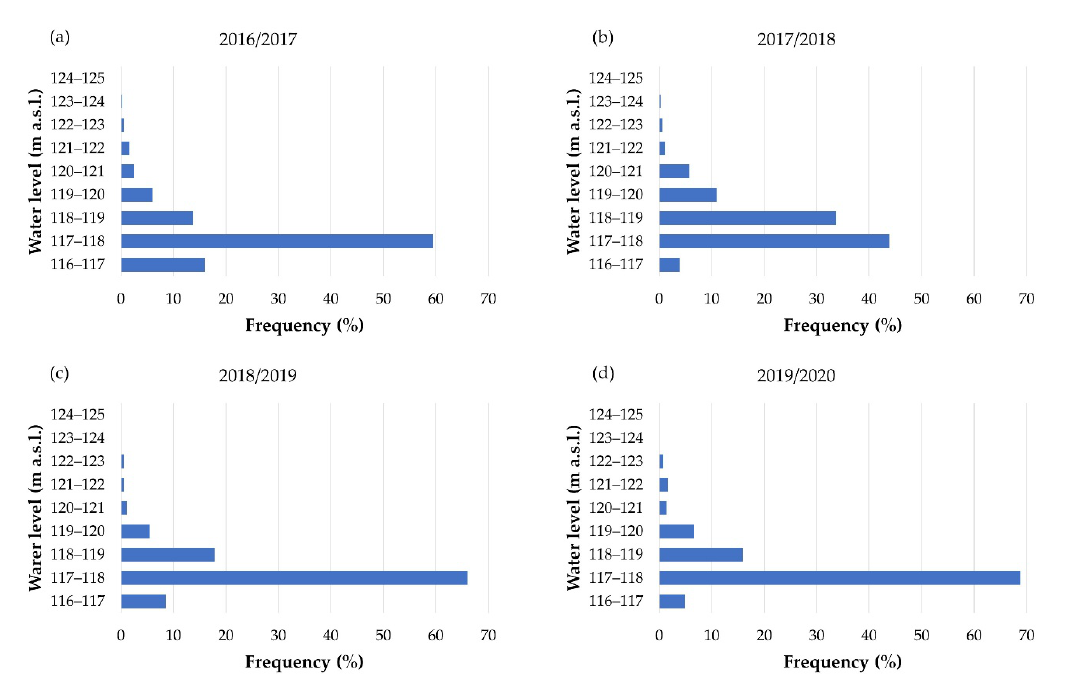
Figure 4. Sava River water level frequency analysis for: ( a ) hydrological year 2016/2017; ( b ) hydro-